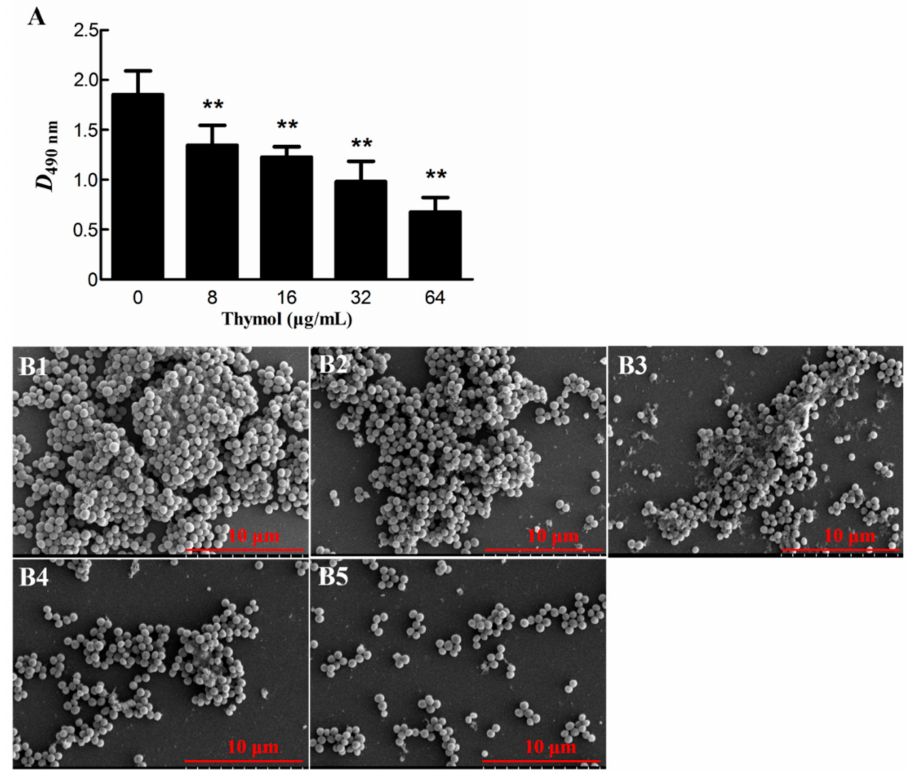
Figure 2. Inhibitory e ff ect of thymol on biofilm formation by TCH1516. ( A ) Results of crystal violet staining. ( B ) Scanning electron microscopy (SEM) images. Biofilms formed by cells treated with 0, 8, 16, 32, and 64 µ g / mL thymol are shown in B1, B2, B3, B4 and B5, respectively. ** p < 0.01 compared with the 0 µ g / mL